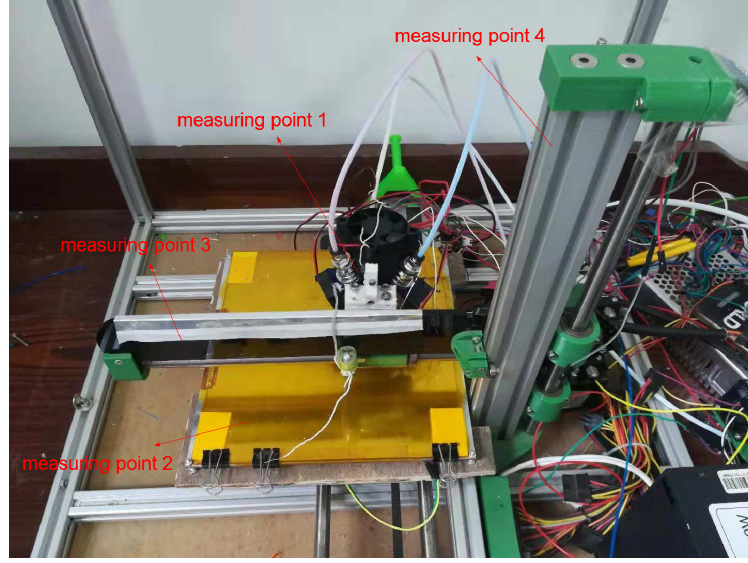
Figure 7. Vibration measuring points arrangement.